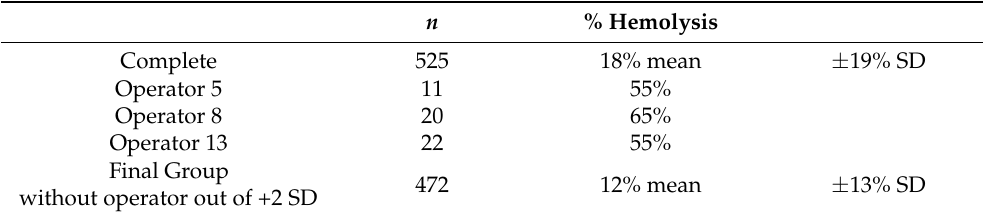
Table 2. Final Group. Operators 5, 8, and 13 showed a percentage of hemolysins of 55%, 65% and 55%, respectively, which was much higher than the average percentage of